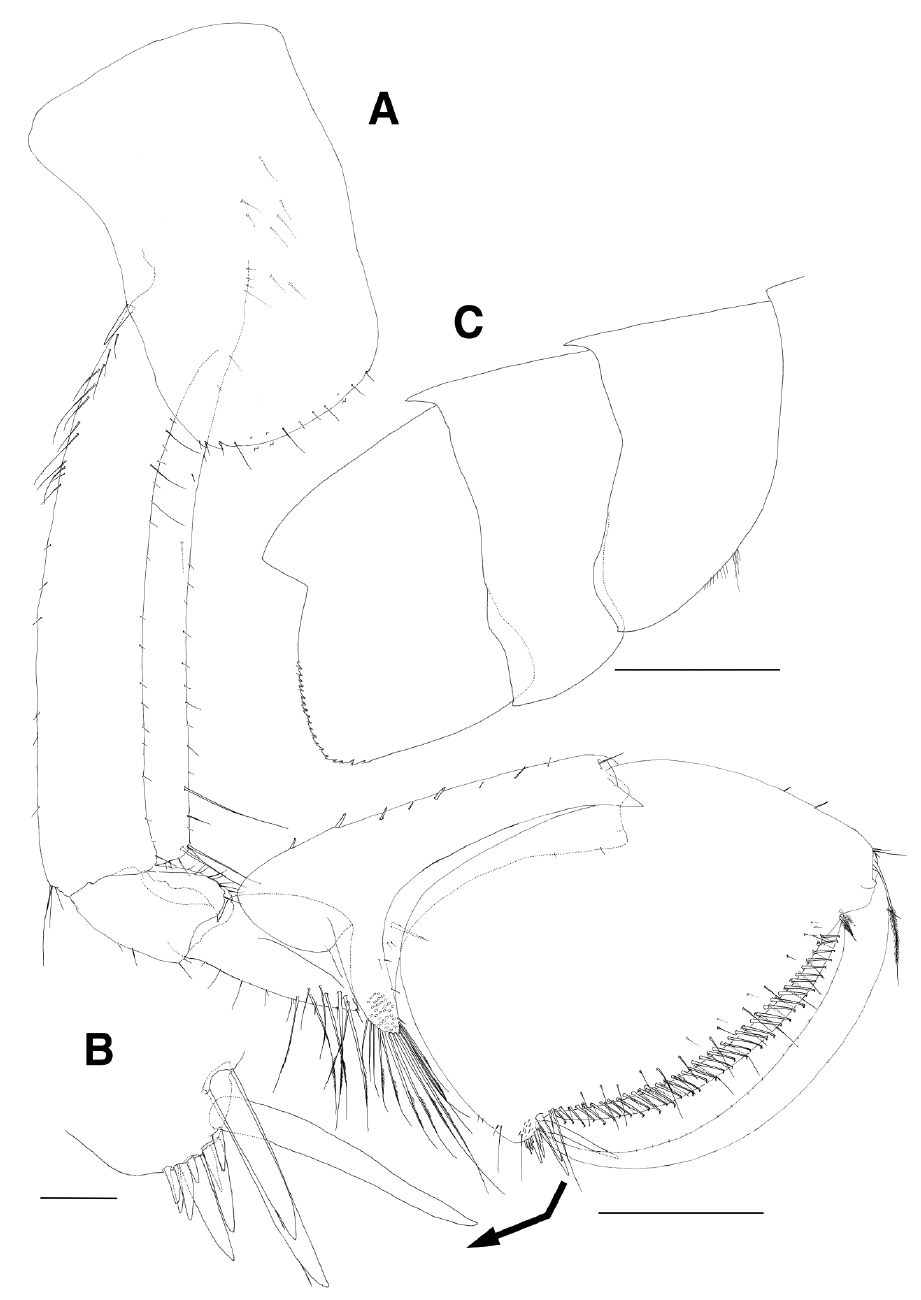
Figure 3. Eusirus bulbodigitus sp. n., holotype, male, NIBRIV0000332003, 11.3 mm. Jeju Island, South Korea. A Gnathopod 2 B Distal setae of posterior margin of propodus on gnathopod 2 C Pleonal epimera. Scale bars=0.05 mm ( B ), 0.4 mm ( A ), 0.5 mm ( C